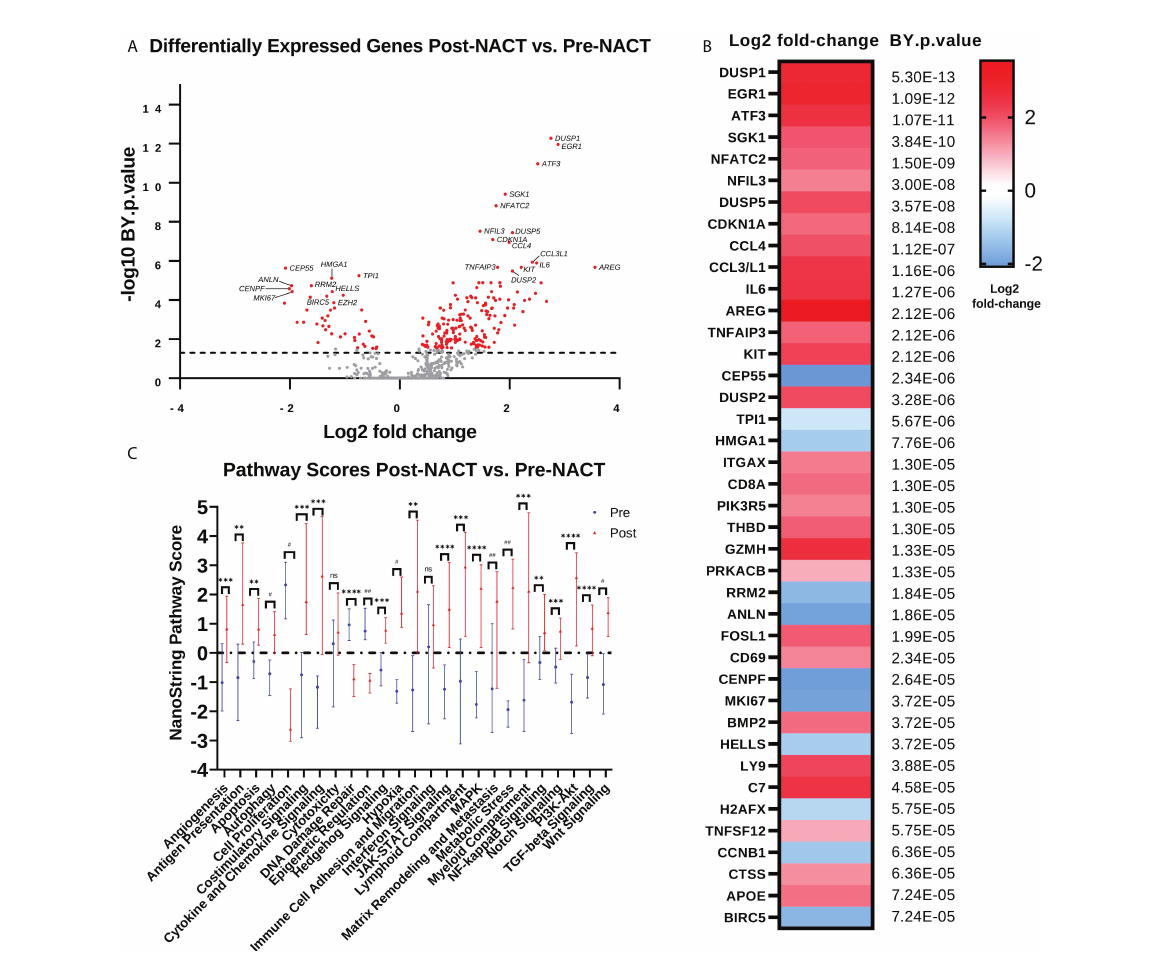
FIGURE 1 Chemotherapy promotes anti-proliferative and immunostimulatory responses but also upregulates genes that may impede the ef fi cacy of chemotherapy. (A) Volcano plot illustrating differential expression of genes post-NACT relative to pre-NACT exposure in matched HGSOC tumor samples, measured by NanoString Human PanCancer IO360. Genes in red indicate Benjamini-Yekutieli (BY) adjusted p-value <0.05. (B) Top 40 differentially expressed genes post-NACT relative to pre-NACT, with Benjamini-Yekutieli adjusted p-value shown to the right. Heat map represents log2 fold-change. (C) NanoString pathway scores pre-NACT versus post-NACT, with symbols representing median scores. Signi fi cance was determined by 2-tailed Wilcoxon matched-pairs signed rank test. **p<0.005; ***p<0.0005; ****p<5e-5; #p<5e-6; ##p<5e-7; ns = not signi fi